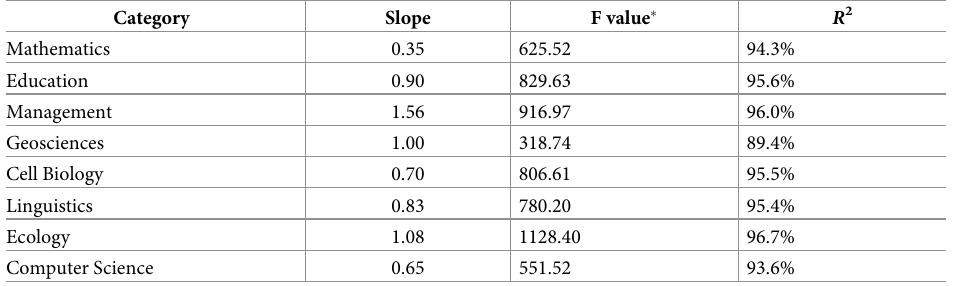
Table 3. Statistical results for the 40-year (1980–2019) linear trend in the number of references cited per research article in eight disciplinary